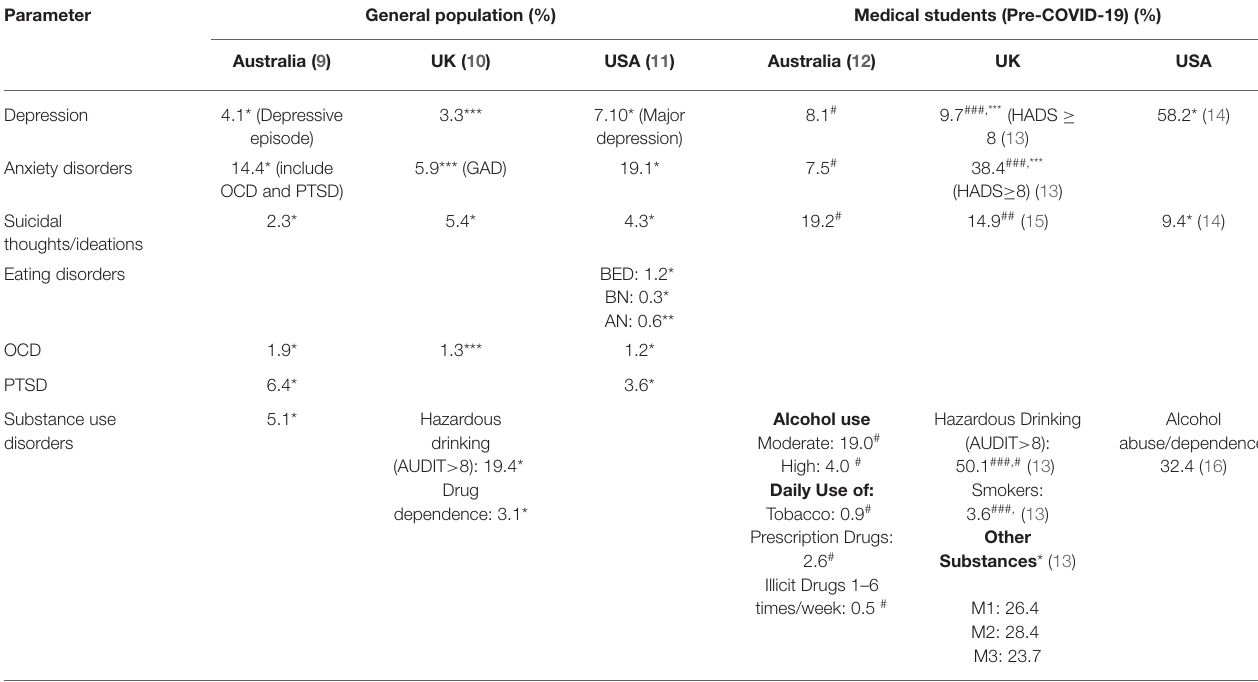
TABLE 1 | Data illustrating the burden of mental health in medical students. Parameter General population (%)